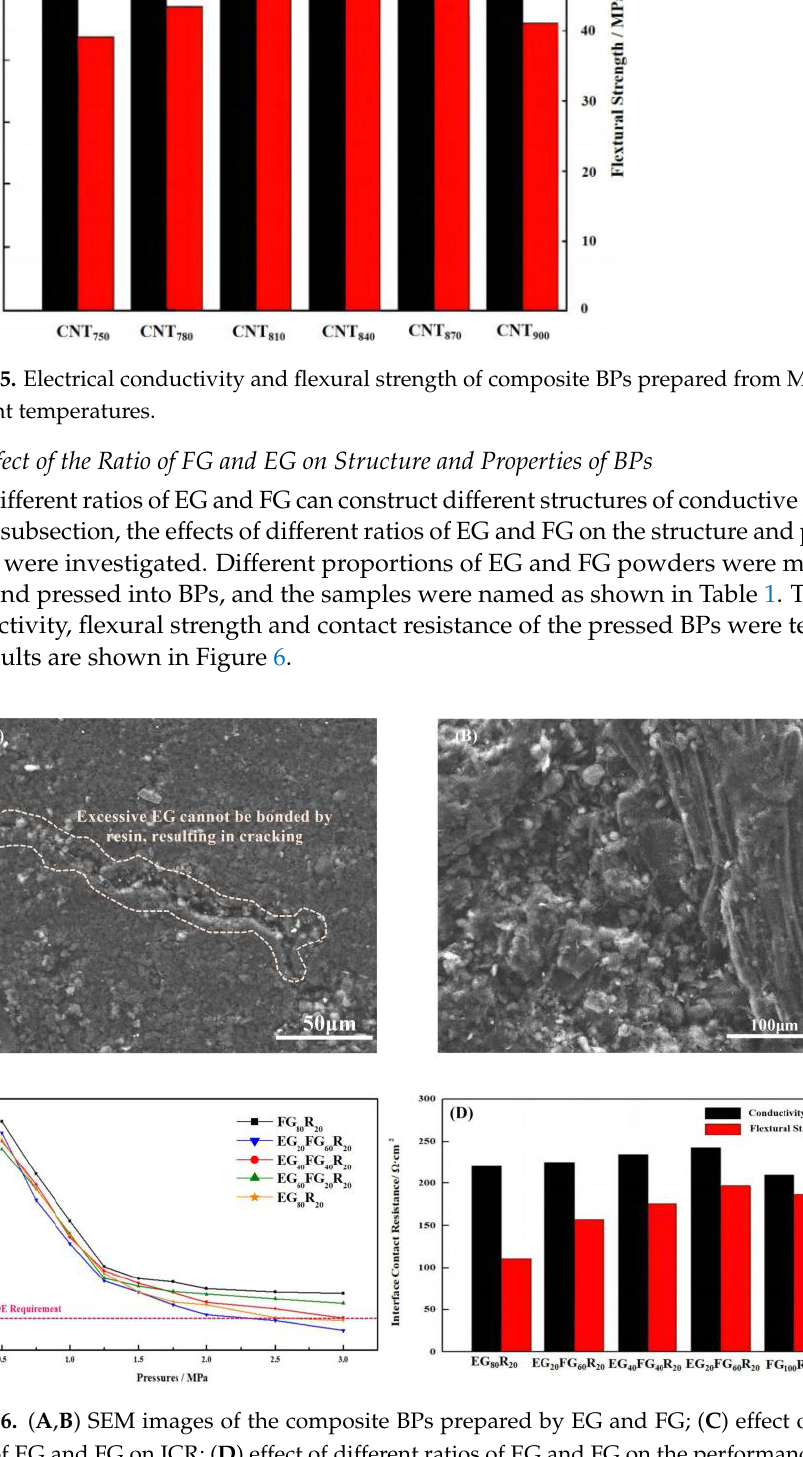
Figure 5. Electrical conductivity and flexural strength of composite BPs prepared from MWCNTs at different temperatures.